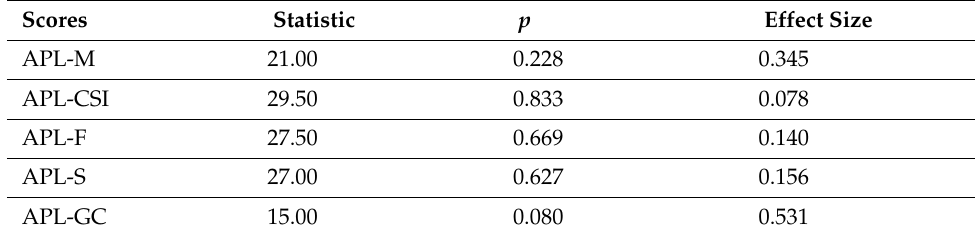
Table 7. t -Test Analysis between Delta values (T1 − T0) between groups.